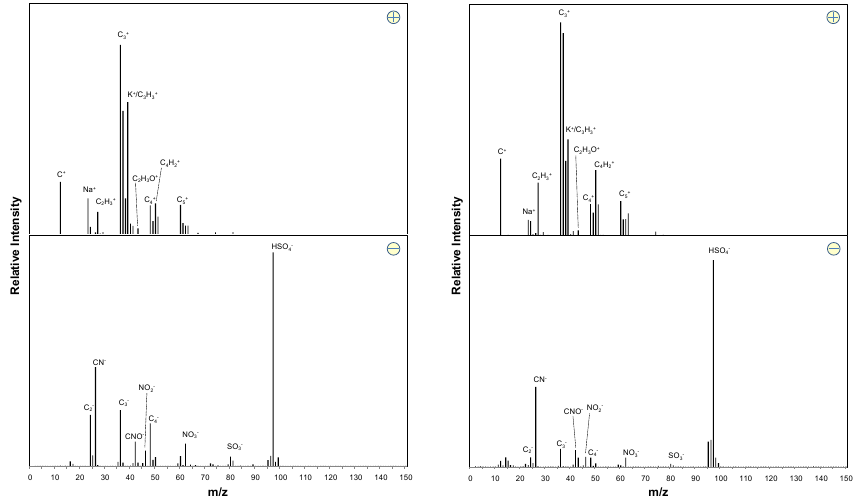
Fig. 4. Average dual ion mass spectra of ambient particles classified as “Coal” (left) and particles sampled during the coal combustion experiment